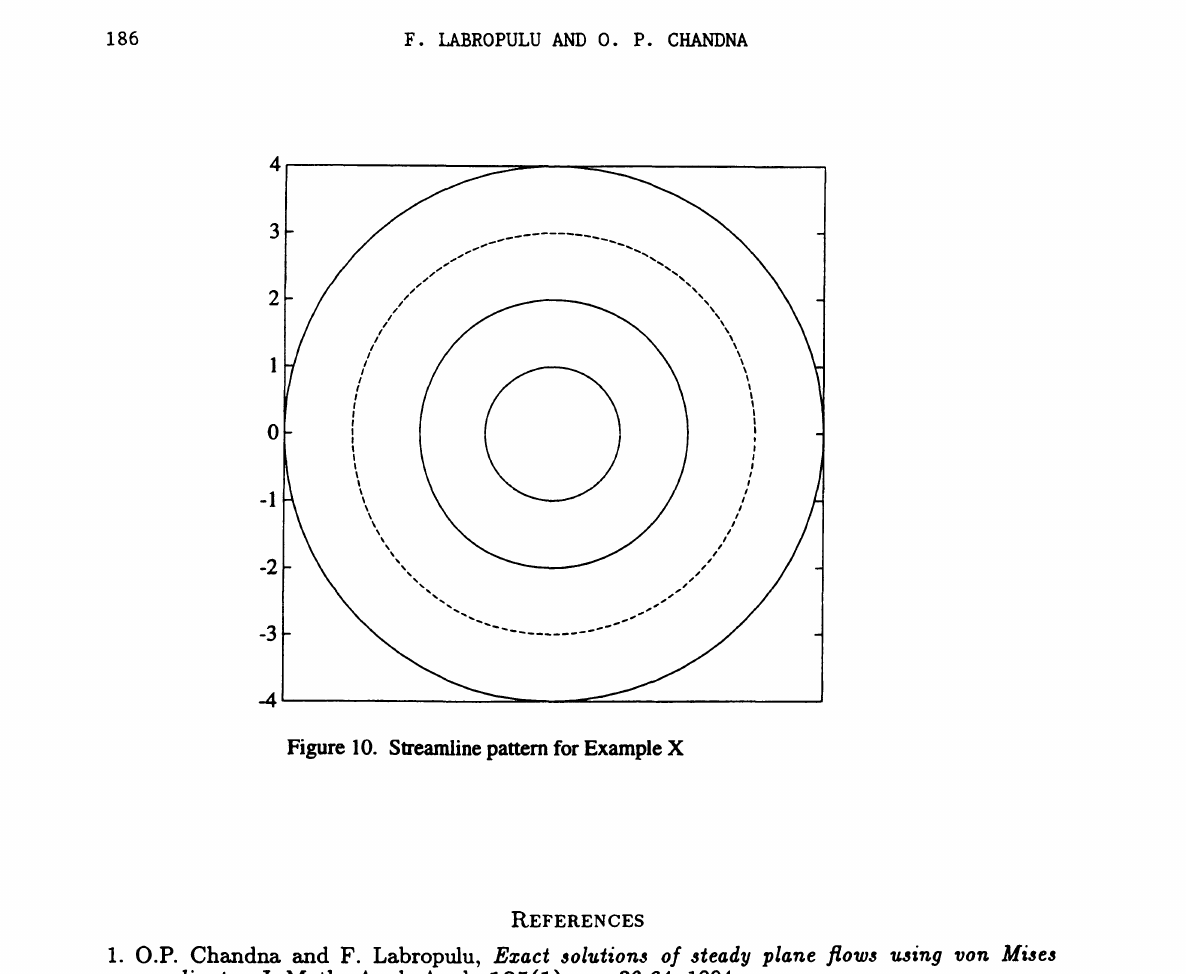
Figure 10. Streamline pattern for Example